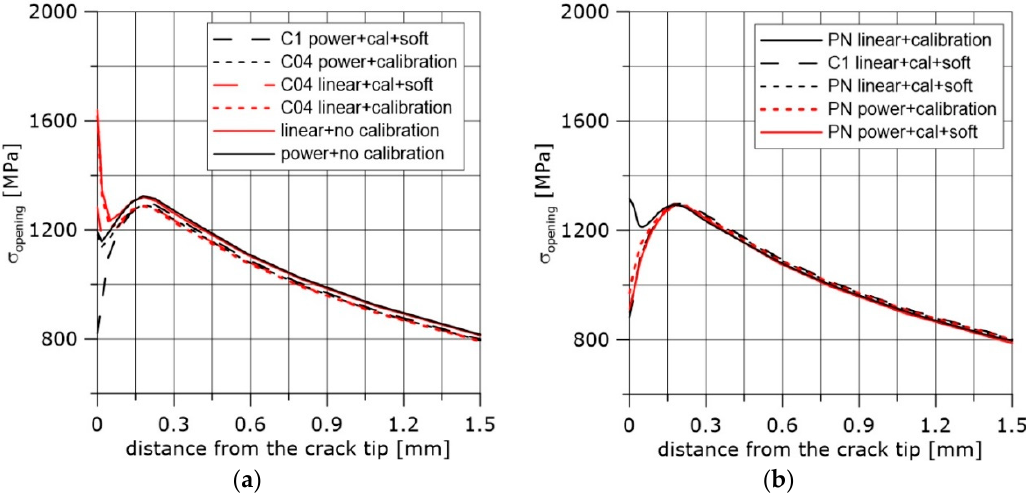
Figure 10. Opening stress distribution computed numerically using stress–strain curves after several calibration procedures. ( a , b ) differ by the method of calibration and specimen used.